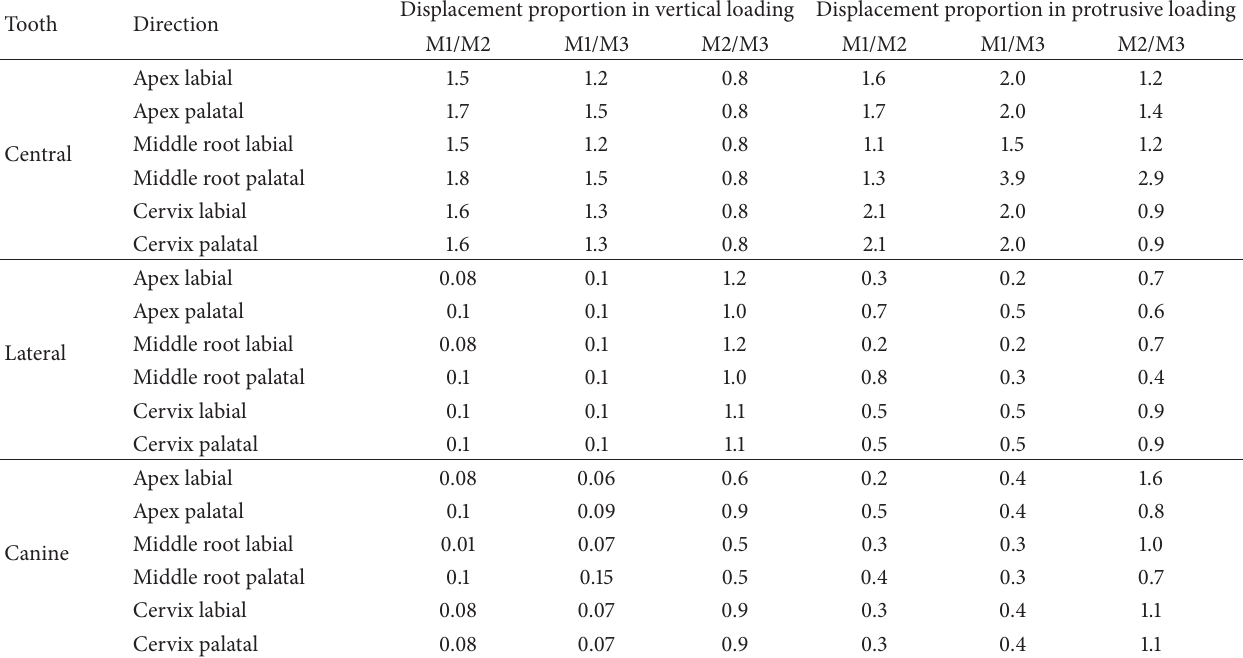
Table 3: Displacement proportion in vertical loading and protrusive loading among the groups. Tooth